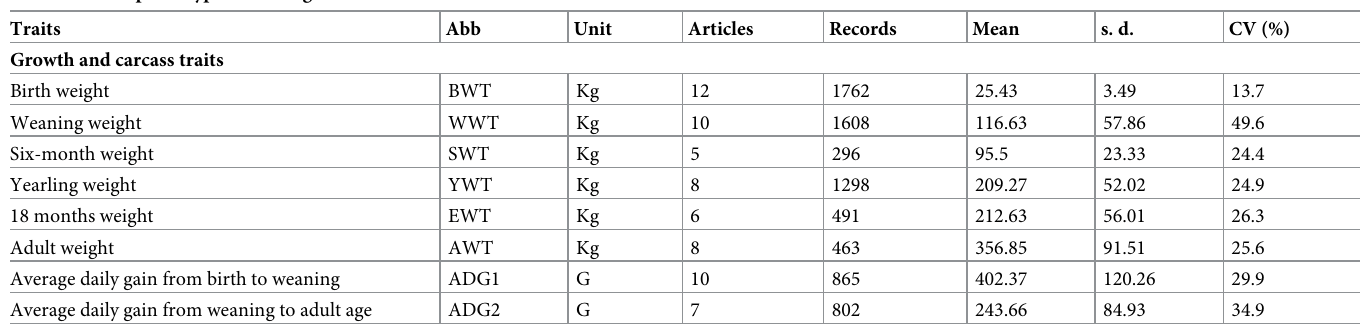
Table 2. Mean phenotypic traits of growth and carcass characteristics in Boran cattle